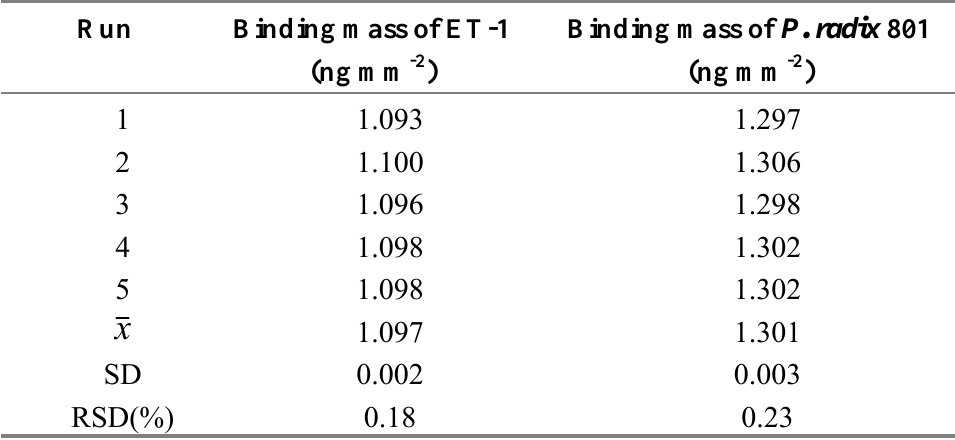
Table 1. Reproducibility and reliability of IAsys.